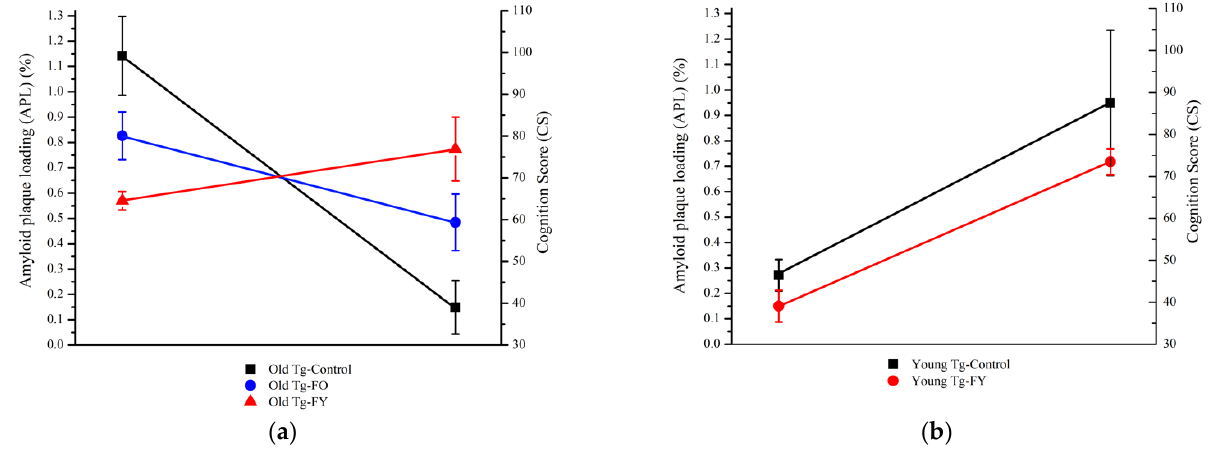
Figure 6. Cognition score based on behavioral study results compared to amyloid plaque burden shows donor age-dependent differences between treated mice groups. ( a ) Mice receiving fecal transplants from younger donors (Old Tg-FY) had higher cognition scores that correlated with lower amyloid loading compared to Old Tg-FO mice that received transplants from age-matched